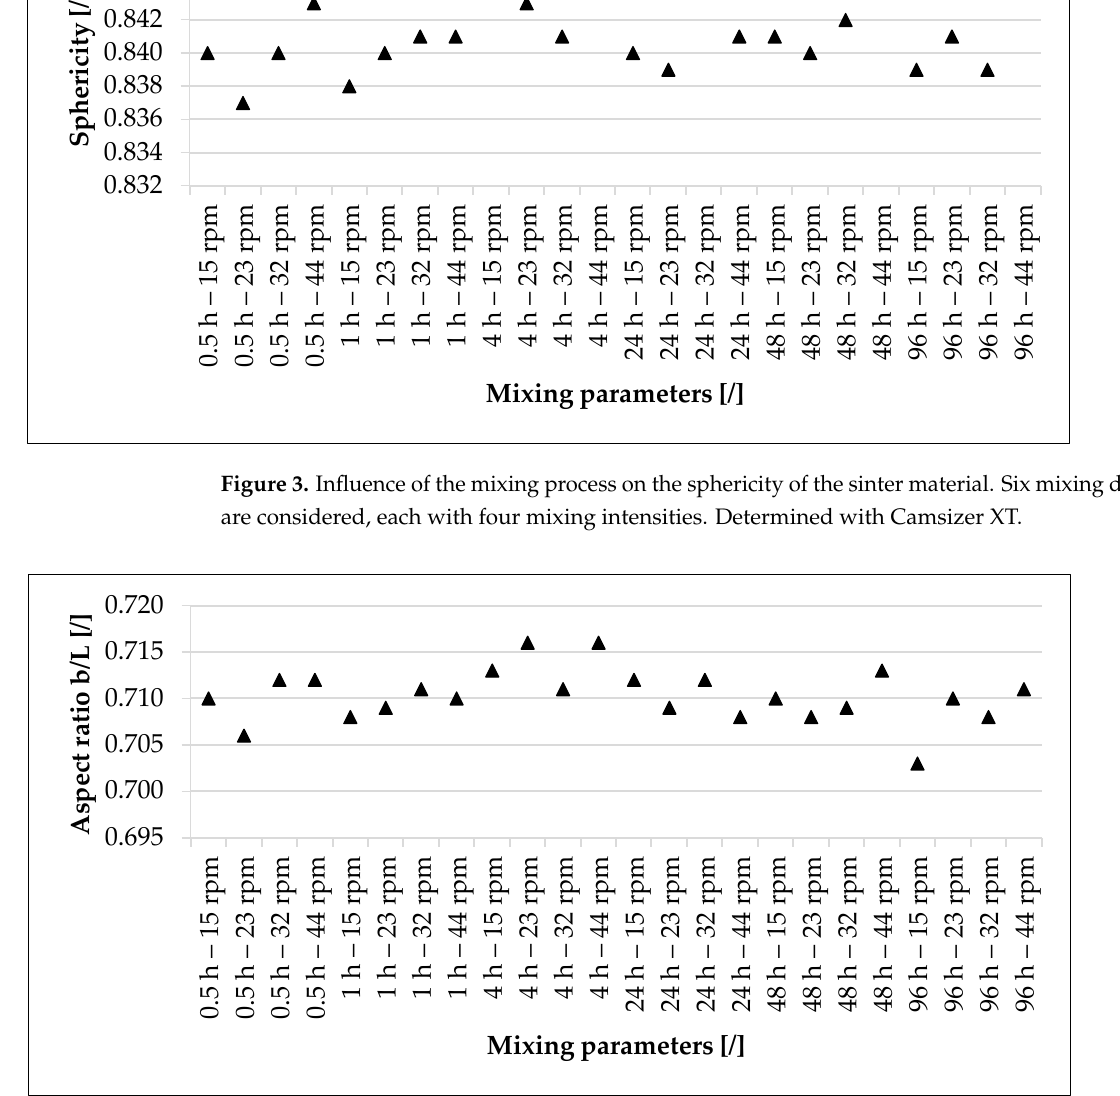
Figure 4. Influence of the mixing process on the aspect ratio of the sinter material. Six mixing durations are considered, each with four mixing intensities. Determined with Camsizer XT.